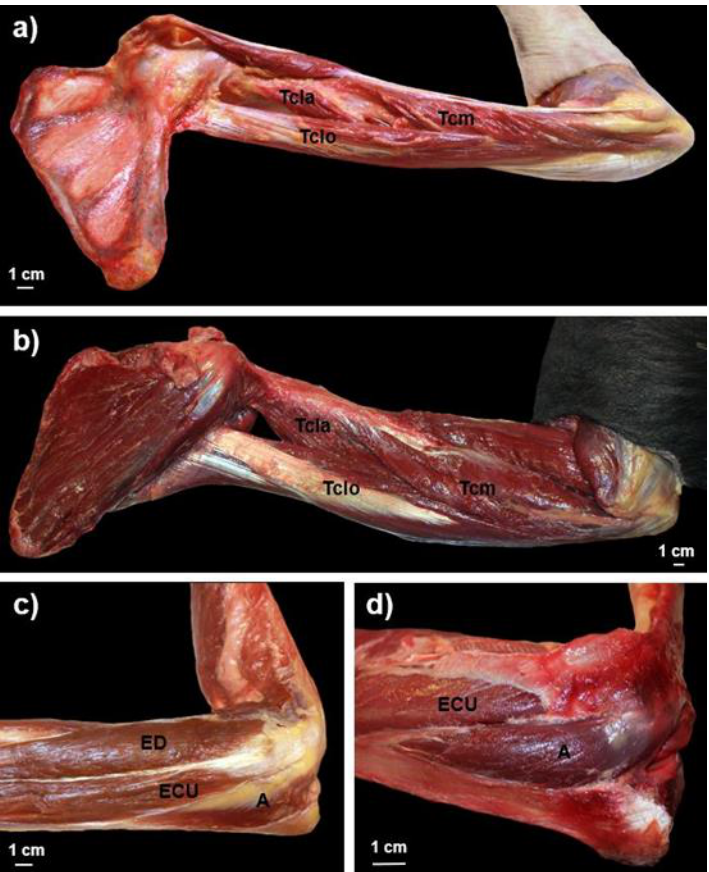
Figure 1. Medial view of a triceps brachii muscle dissection in ( a ) Homo sapiens and ( b ) Pan troglodytes and lateral view of an anconeus muscle dissection in ( c ) Homo sapiens and ( d ) Pan troglodytes . Tclo = Triceps brachii caput longum; Tcla = Triceps brachii caput laterale; Tcm = Triceps brachii caput mediale; A = Anconeus; ED = Extensor digitorum; ECU = Extensor carpi